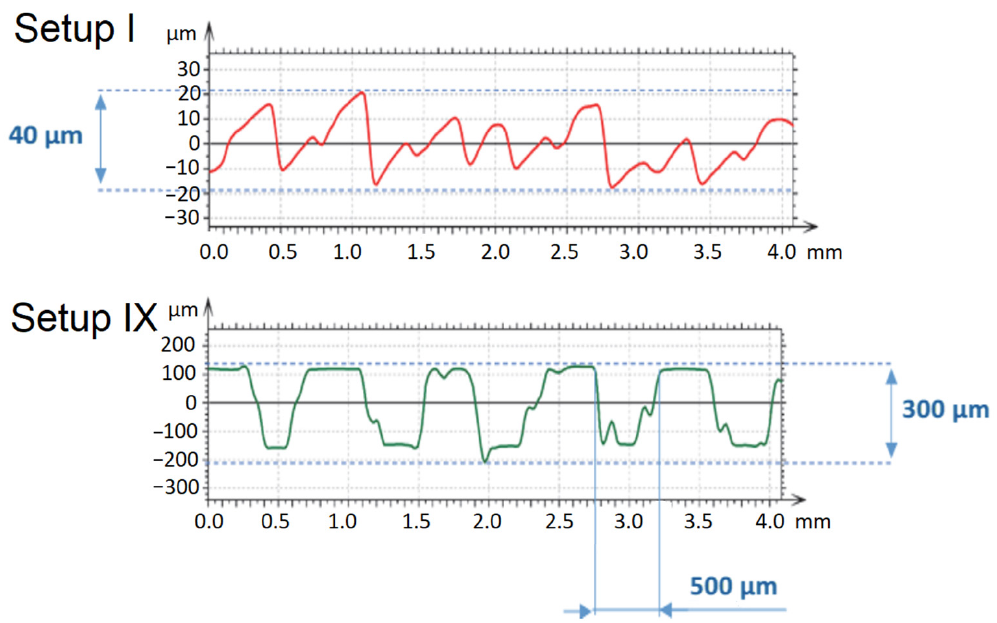
Figure 9. Extracted pro fi les from FDM surfaces for setup I ( up ) and setup IX ( down ).